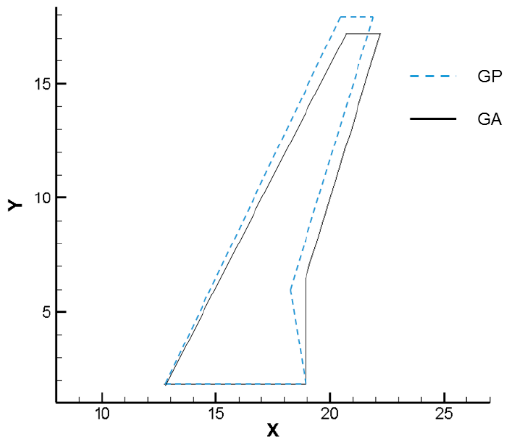
Figure 8. Cruise shapes: the optima by the GP and GA methods.